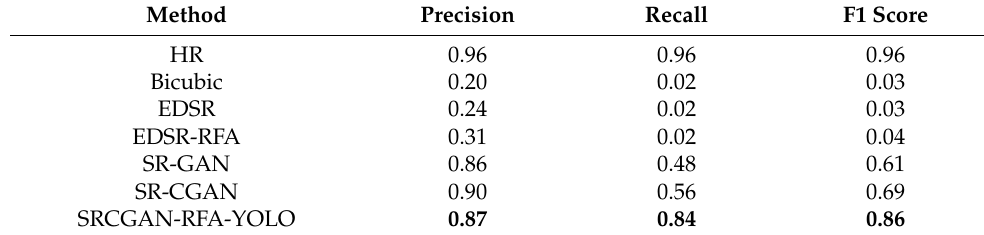
Table 5. Detection performance on ISPRS Potsdam dataset for a scale factor of 16 and IoU of 0.10. Method Precision